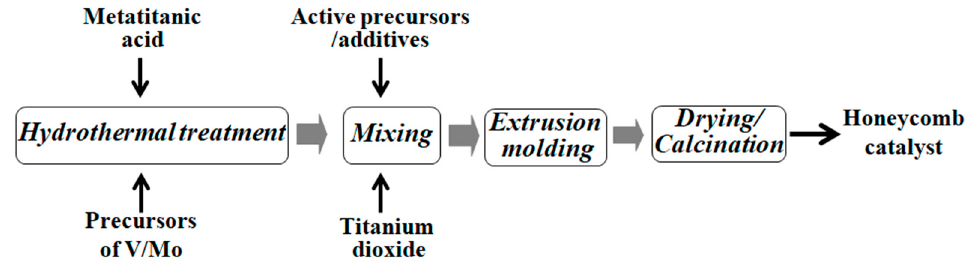
Figure 9. The improved process for the honeycomb product using both the filter cake and industrial titanium dioxide as Ti sources.